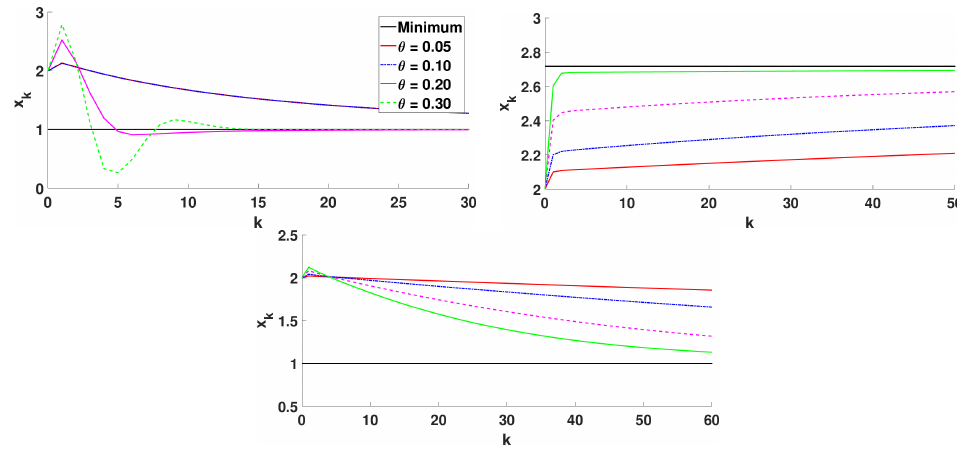
Figure 2. Algorithm 1 for different step sizes, θ .